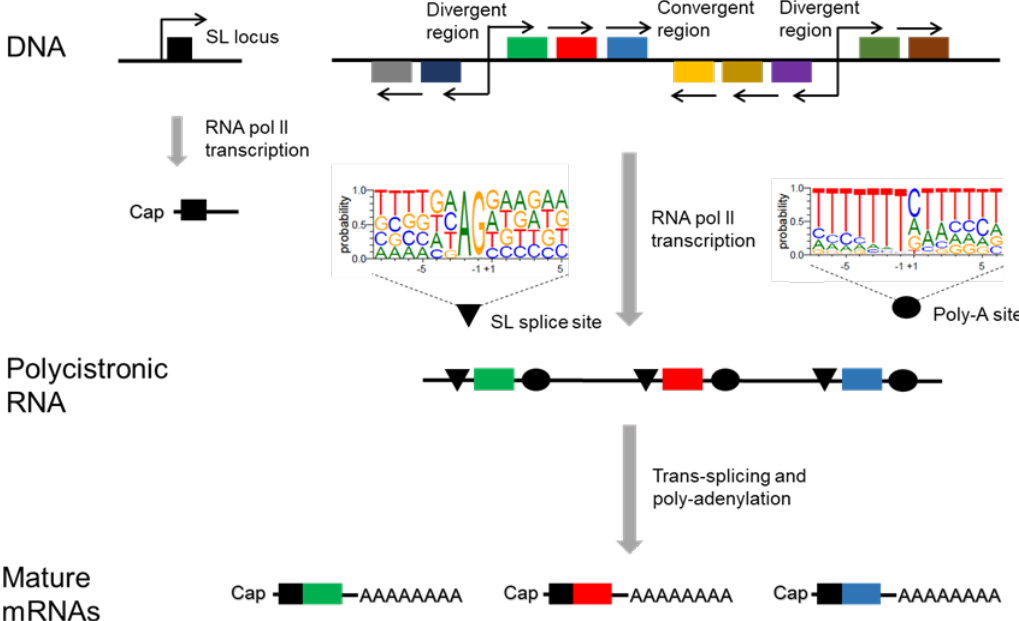
Figure 2. Transcription process of T. cruzi . RNA polymerase II produces polycistronic RNAs that are modified by trans-splicing and polyadenylation. The final mature mRNAs contain the Cap with the SL and the poly A tail. SL: spliced leader.